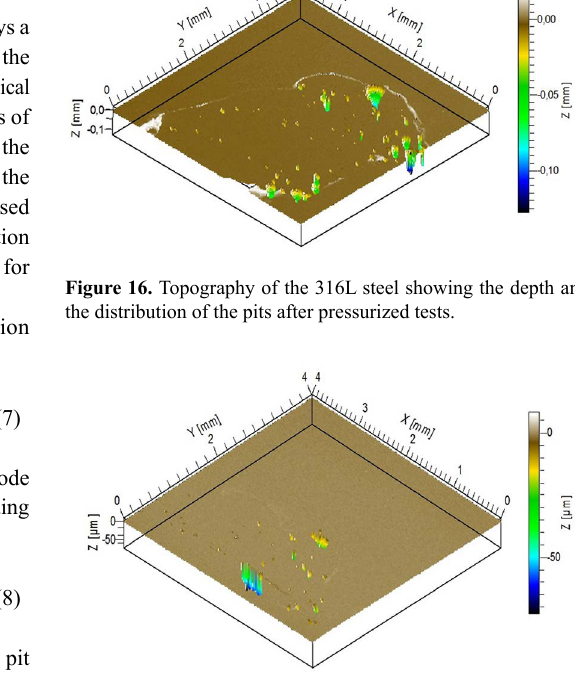
The deepest pit found on the surface of the 316L surface possesses 0.20 mm and for the 317L steel, 0.026 mm.